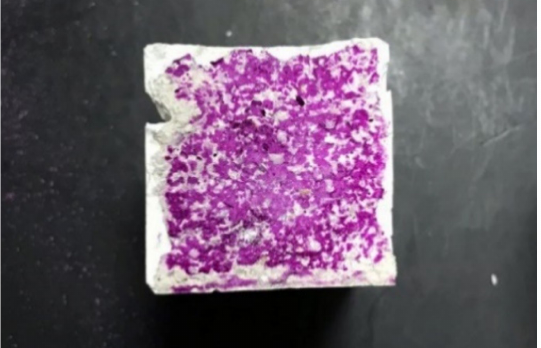
Figure 9. Phenolphthalein test, AC20 specimen (varied w/b ratio and percentage of WPC, 0.4% AEG agent